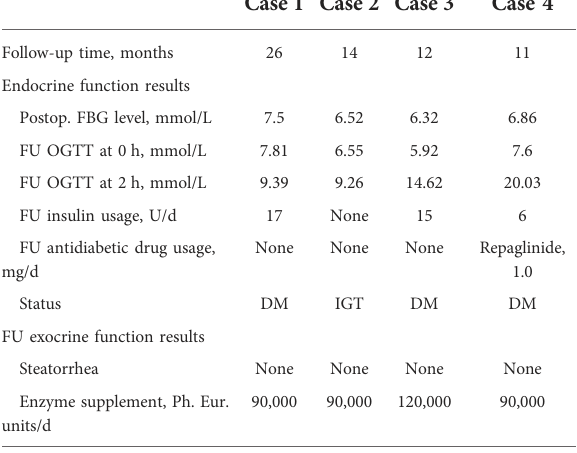
TABLE 4 Postoperative pancreatic endocrine and exocrine function results.